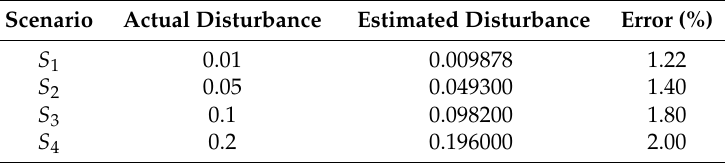
Table 3. Disturbance estimation using swing equation.